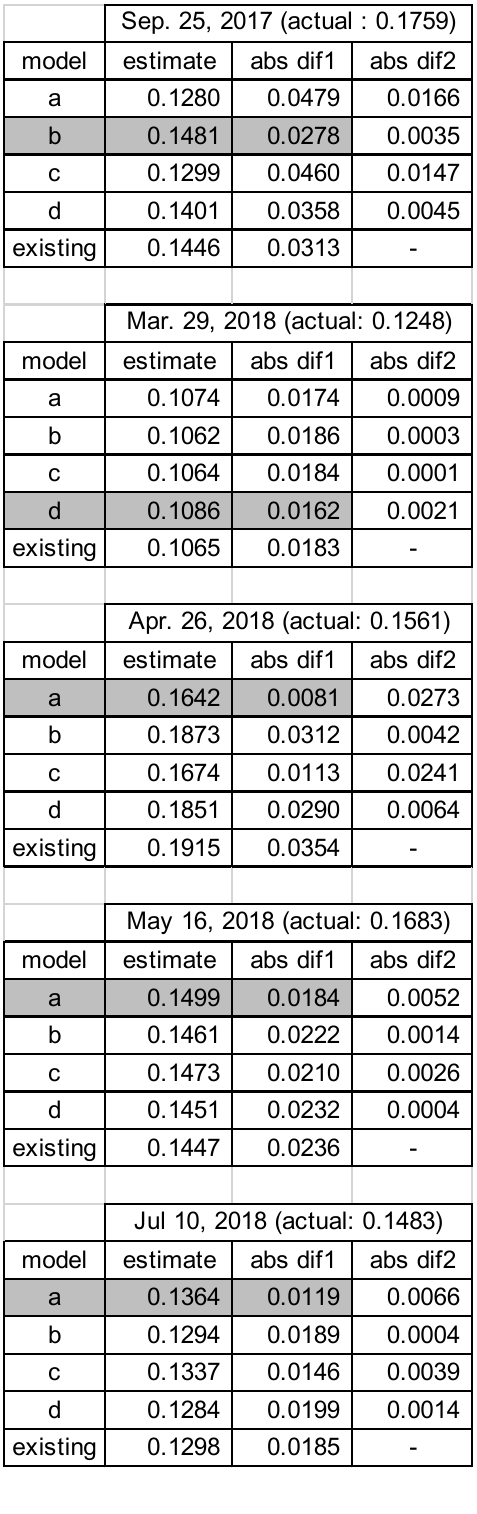
Table 4. Broadband albedo obtained by applying the NTB conversion formula generated by calibration with in situ measurements. Gray column denotes the best result. “Abs dif1” and “abs dif2” denote the differences from the actual value and from the value estimated using the existing model,